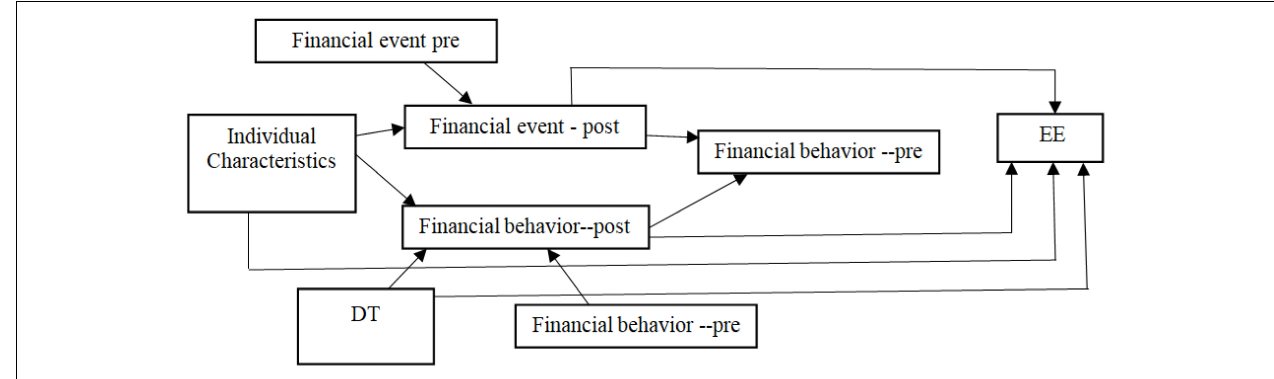
FIGURE 1 | Study research model. EE, Emotional Exhaustion; DT, Deliberate Thinking.